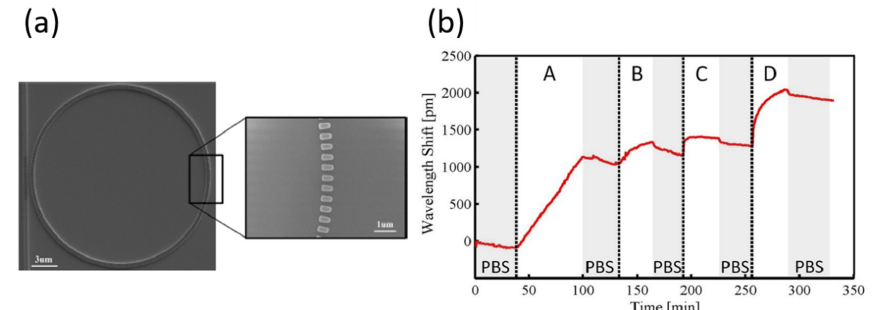
Figure 20. ( a ) SEM images of SWG ring resonator. ( b ) Wavelength shifts as a result of anti-streptavidin (A), BSA (B), streptavidin (C), and biotinylated BSA (D) as the target analyte. The shaded gray lines along the graph indicate PBS rinsing. Reproduced from ref. [129] with permission © The Optical Society of America.